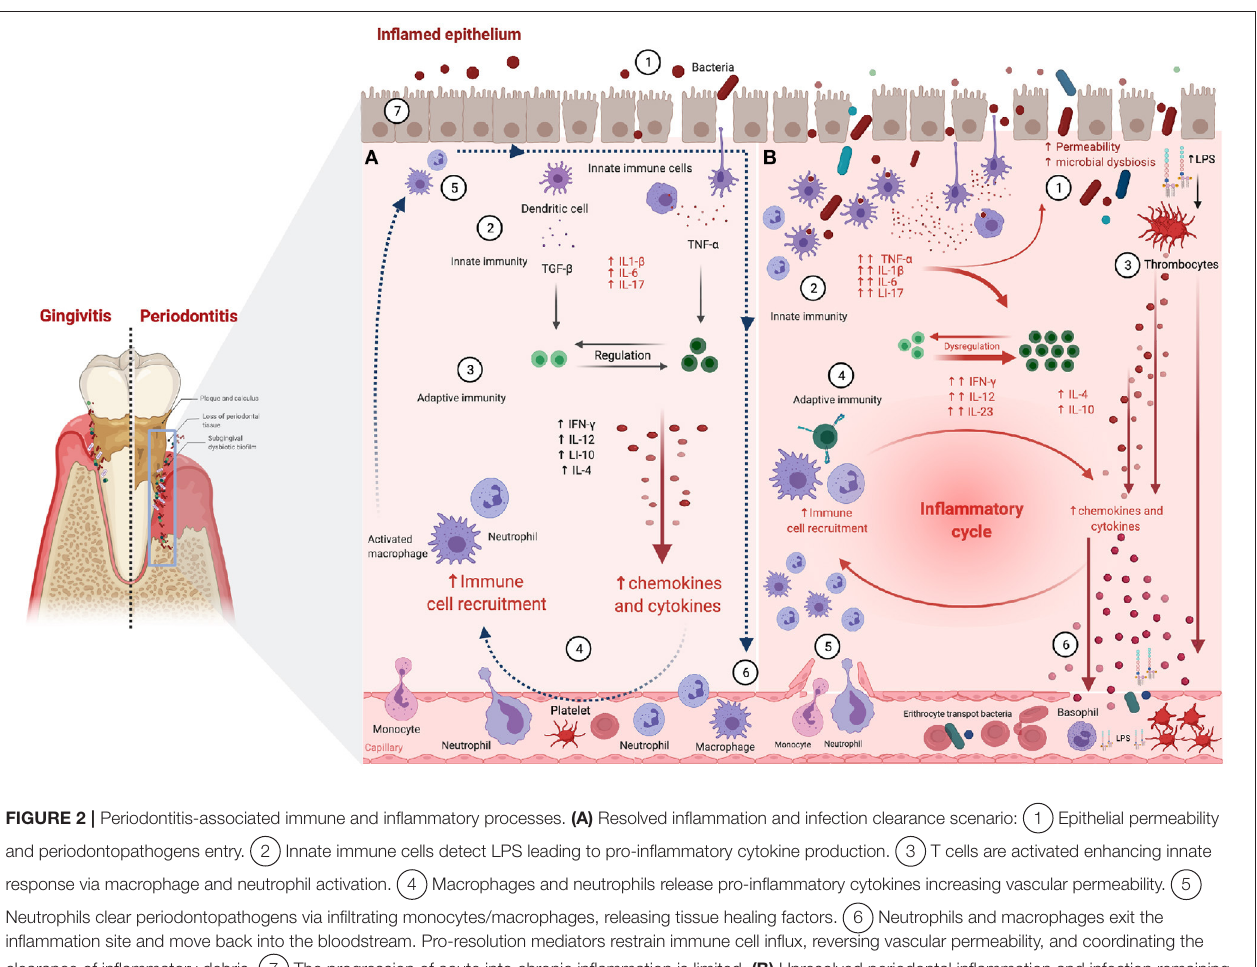
FIGURE 2 | Periodontitis-associated immune and inflammatory processes. (A) Resolved inflammation and infection clearance scenario: 1 Epithelial permeability and periodontopathogens entry. 2 Innate immune cells detect LPS leading to pro-inflammatory cytokine production. 3 T cells are activated enhancing innate response via macrophage and neutrophil activation. 4 Macrophages and neutrophils release pro-inflammatory cytokines increasing vascular permeability. 5 Neutrophils clear periodontopathogens via infiltrating monocytes/macrophages, releasing tissue healing factors. 6 Neutrophils and macrophages exit the inflammation site and move back into the bloodstream. Pro-resolution mediators restrain immune cell influx, reversing vascular permeability, and coordinating the clearance of inflammatory debris. 7 The progression of acute into chronic inflammation is limited. (B) Unresolved periodontal inflammation and infection remaining scenario: 1 Greater epithelial permeability and massive entry of periodontopathogens. 2 Innate immune cells detect LPS, leading to pro-inflammatory cytokine production and phagocyte activation. 3 LPS activates thrombocytes, enhancing antimicrobial peptides and cytokine production. 4 Adaptive immune cells activate macrophages and neutrophils releasing pro-inflammatory cytokines. 5 Vascular permeability increases and leukocyte influx persist in inflamed